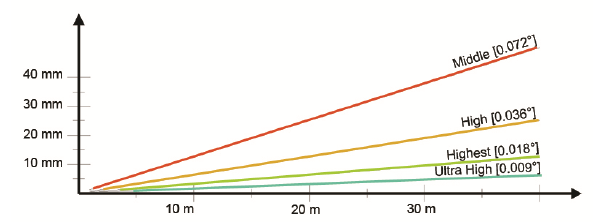
Figure 9. Angular preset resolution for HDS 6000 scanner and corresponding linear distances between measured points The ability to record small details is related to accuracy and to beam diameter; both these parameters are distance related (Pesci et al., 2011). As we acquired data from short or very short distances (shorter than 7 meters for the big vault and shorter than 4 meters in the small vaults), we can state that the adopted instruments meets the requirements of this case study.